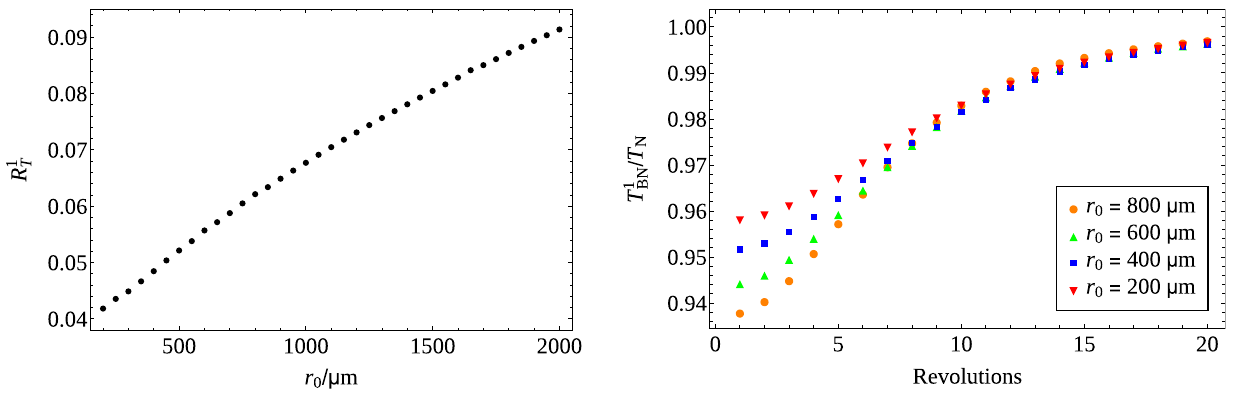
/ T and T N as a func- panel: The ratio T i N for the first 20 revolutions for different initial BN BN conditions, where r 0 = 800 μ m (orange circles), r 0 = 600 μ m (green . Right T